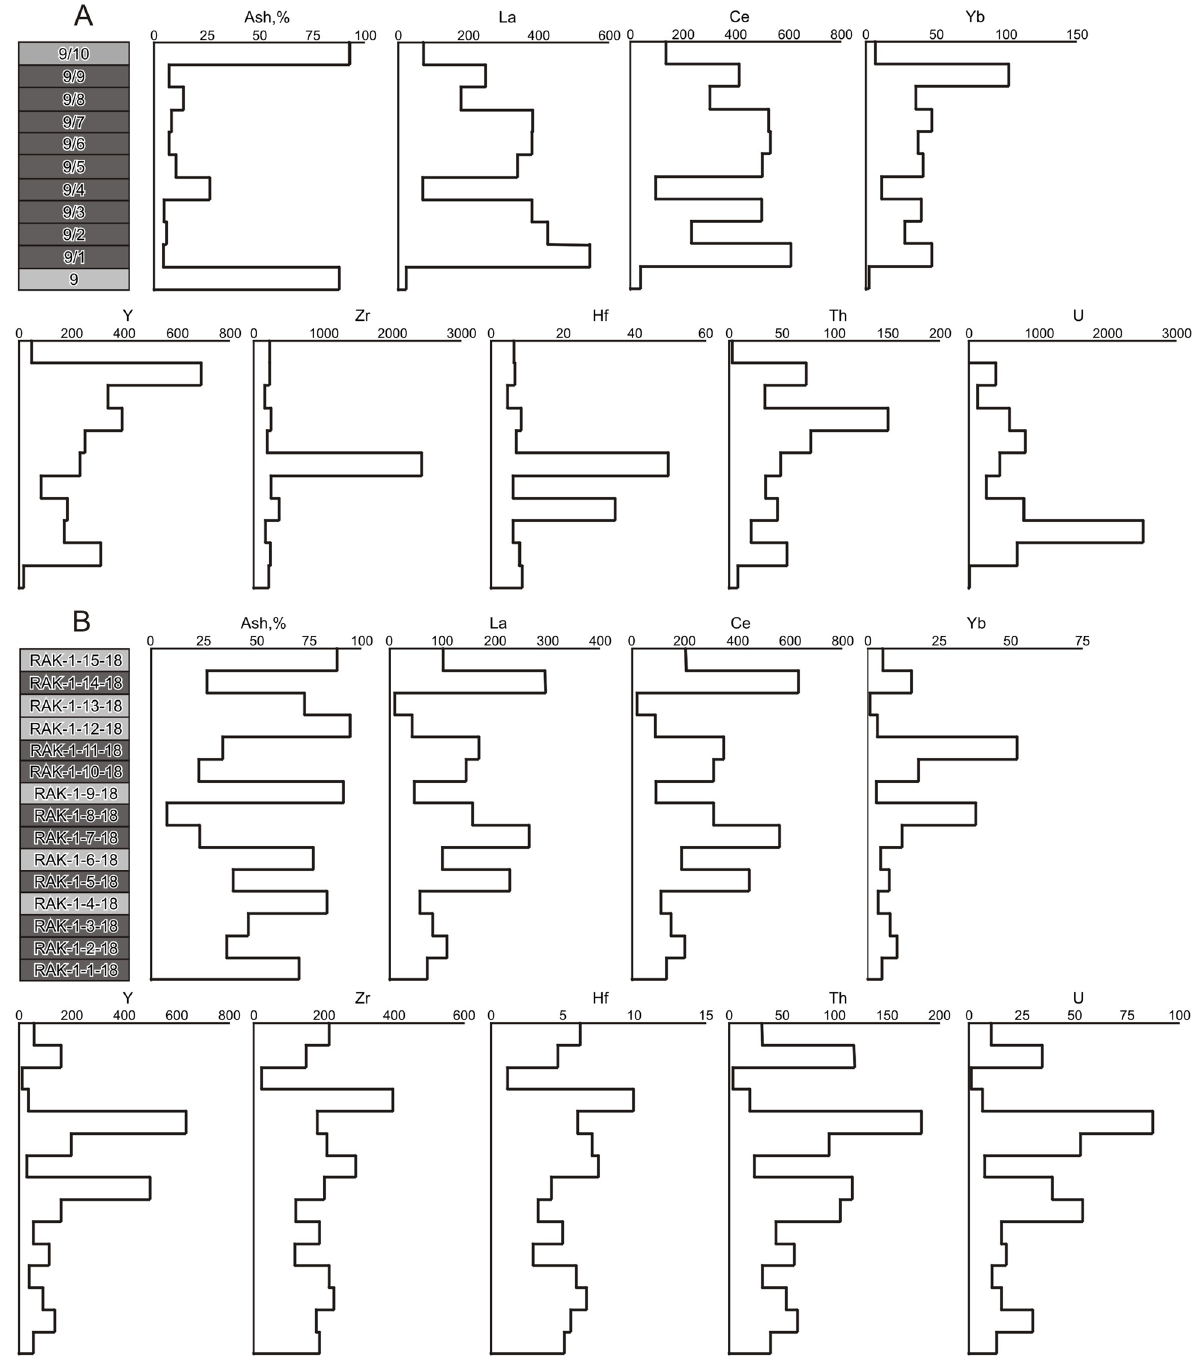
Fig. 5 Variation of ash content and concentrations of individual rare elements. a “West” section; b “East”